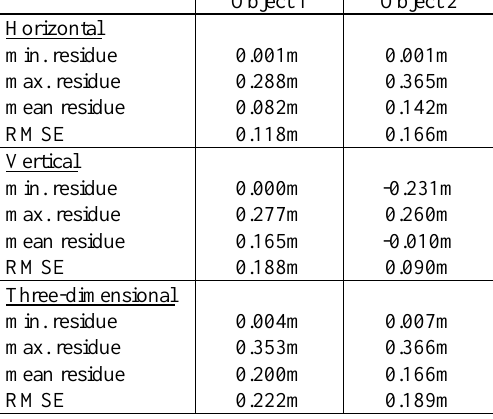
Table 1. Results of internal accuracy assessment.